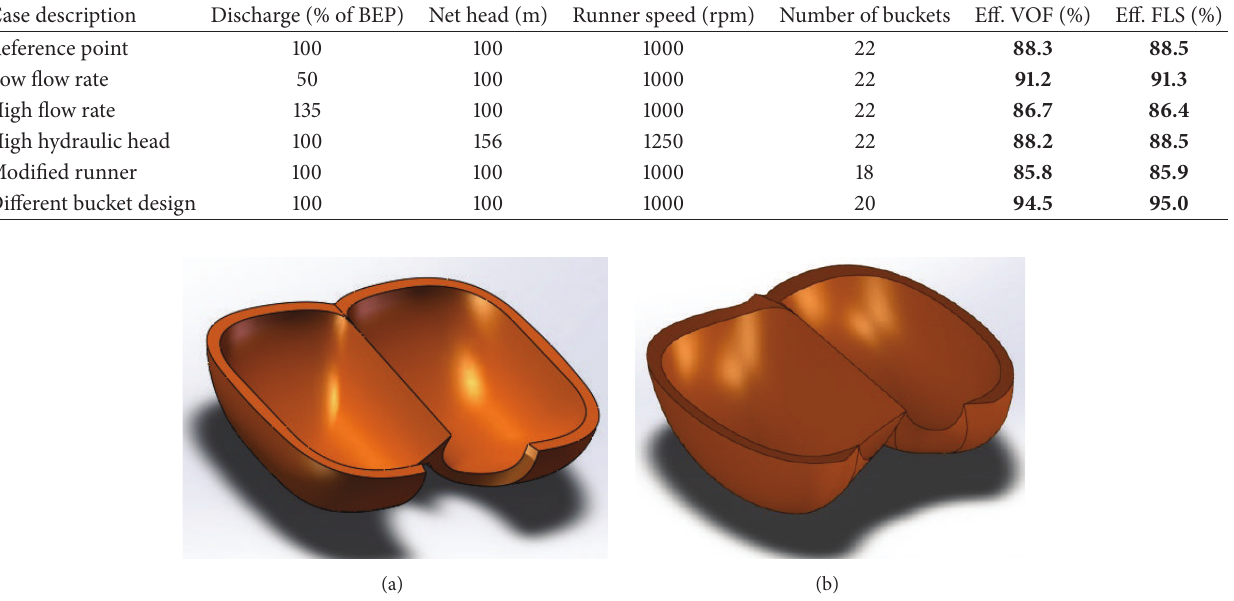
Table 1: Comparison of FLS and Fluent computational results.